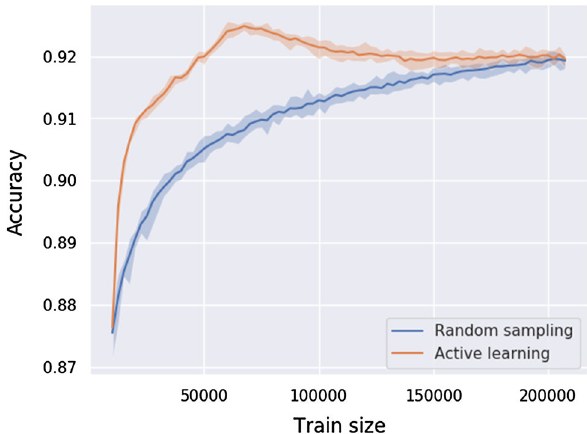
Fig. 4 Accuracy development on model exclusion of the 19- dimensionalmodelfornewphysics(pMSSM)forrandomsamplingand active learning using a random forest as algorithm and an infinite pool. True labeling was provided by a machine learning algorithm trained on model points and labels provided by ATLAS [1]. Here active learning is vastly superior over random sampling, yielding a gain in computational time of a factor of 5–6. The bands around the curves show the range in which all curves of that colour lie when the experiment was repeated 7